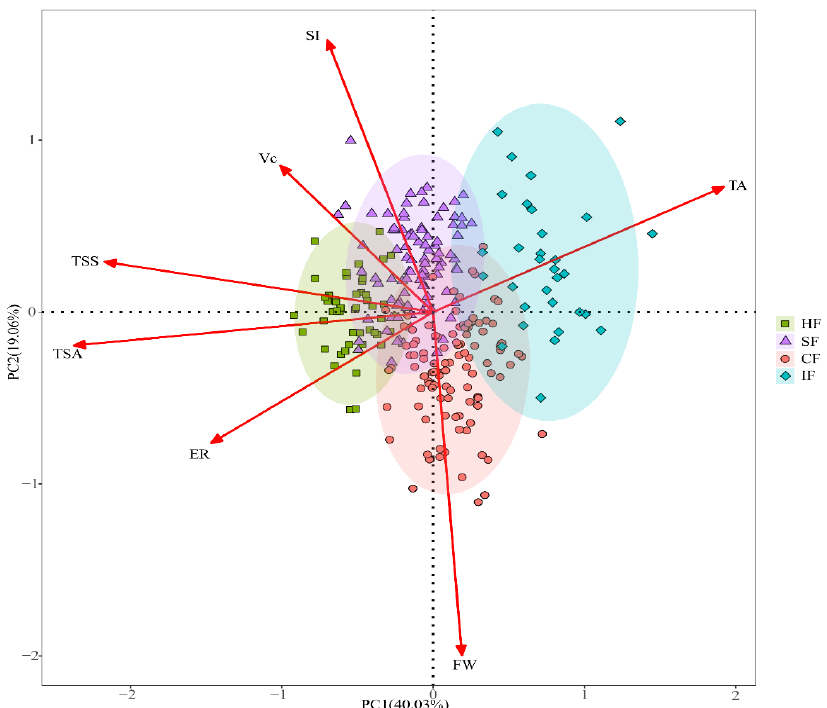
Figure 2. PCA analysis of fruit quality in 4 citrus cultivars. HF (47 samples): high‐quality fruit, SF